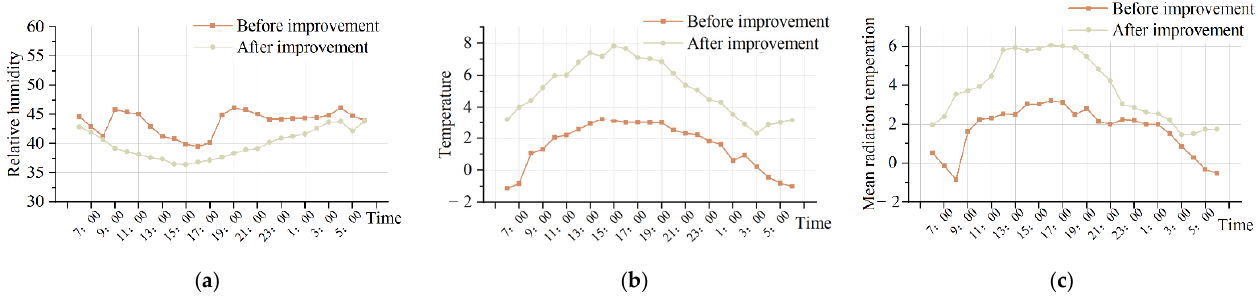
Figure 10. The 24 h simulation comparison of the physical environment before and after improve- ment in Bedroom D on the 15–16 January. ( a ) The 24 h simulation comparison of indoor humidity before and after improvement, ( b ) The 24 h simulation comparison of the indoor air